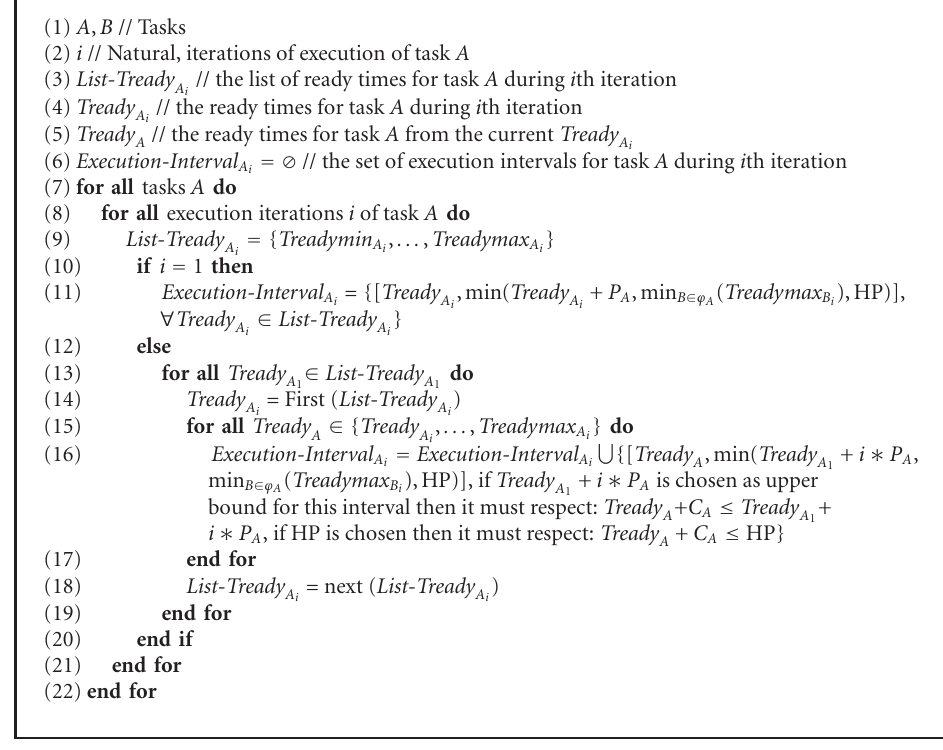
Algorithm 2: Search of execution